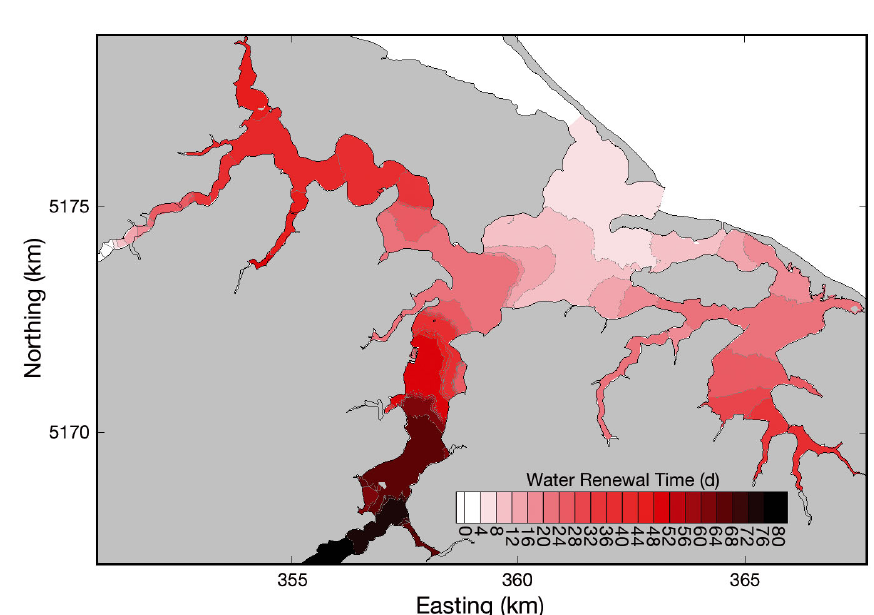
Fig. 5. Spatial distribution of the water renewal time estimated from the numerical model results under tidal and river dis- charge